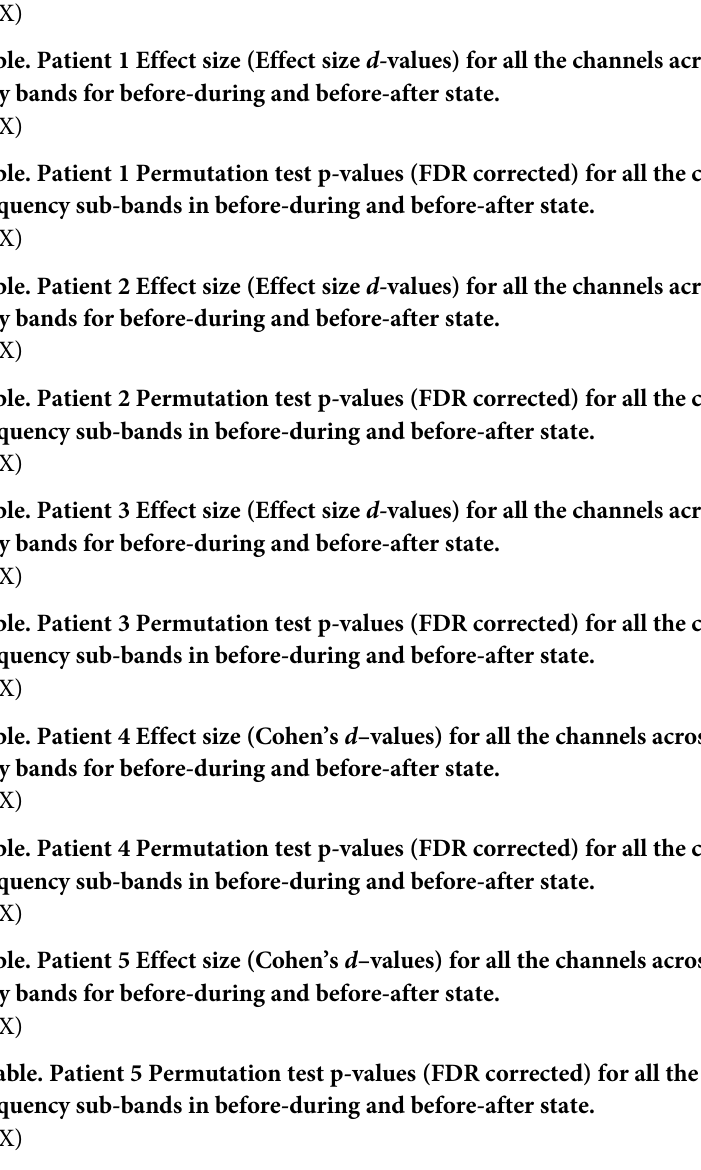
S7 Fig. Correlation coefficient time series. (A)-(E) Sub-band normalised correlation coeffi- cient time series for Patient 1-Patient 5. (F)-(H) Broandband average time series for Patient 1, Patient 2 and Patient 4. (DOCX) S8 Fig. Path length time series. (A)-(E) Sub-band path length time series for Patient 1-Patient 5. (F)-(H) Broandband path length time series for Patient 1, Patient 2 and Patient 4. (DOCX) S9 Fig. Clustering coefficient time series. (A)-(E) Sub-band normalised clustering coefficient time series for Patient 1-Patient 5. (F)-(H) Broandband average time series for Patient 1, Patient 2 and Patient 4. (DOCX) S1 Table. Patient 1 Effect size (Effect size d- values) for all the channels across all the fre- quency bands for before-during and before-after state. (DOCX) S2 Table. Patient 1 Permutation test p-values (FDR corrected) for all the channels across all frequency sub-bands in before-during and before-after state. (DOCX) S3 Table. Patient 2 Effect size (Effect size d- values) for all the channels across all the fre- quency bands for before-during and before-after state. S4 Table. Patient 2 Permutation test p-values (FDR corrected) for all the channels across all frequency sub-bands in before-during and before-after state. (DOCX) S5 Table. Patient 3 Effect size (Effect size d- values) for all the channels across all the fre- quency bands for before-during and before-after state. (DOCX) S6 Table. Patient 3 Permutation test p-values (FDR corrected) for all the channels across all frequency sub-bands in before-during and before-after state. (DOCX) S7 Table. Patient 4 Effect size (Cohen’s d –values) for all the channels across all the fre- quency bands for before-during and before-after state. S8 Table. Patient 4 Permutation test p-values (FDR corrected) for all the channels across all frequency sub-bands in before-during and before-after state. (DOCX) S9 Table. Patient 5 Effect size (Cohen’s d –values) for all the channels across all the fre- quency bands for before-during and before-after state. (DOCX) S10 Table. Patient 5 Permutation test p-values (FDR corrected) for all the channels across all frequency sub-bands in before-during and before-after state.